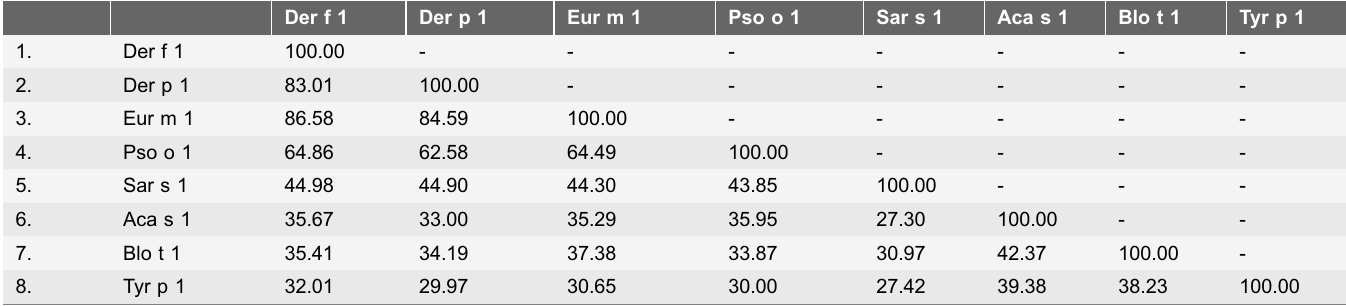
Table 4. Percent identity matrix of aligned group1 allergens.